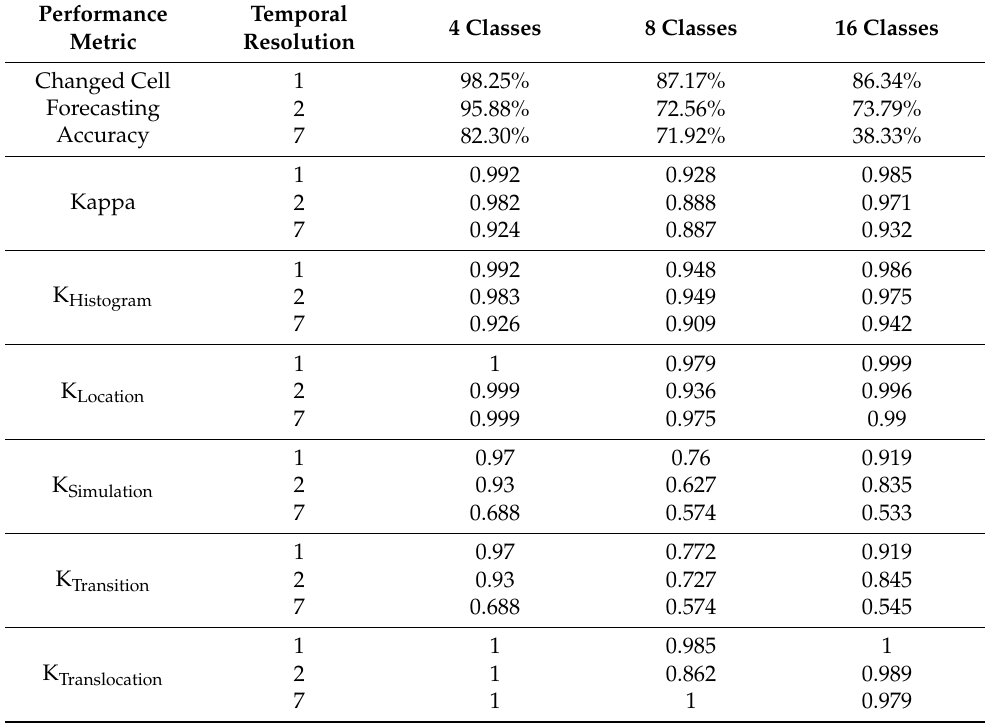
Table 10. Performance metrics obtained using Subset C of the hypothetical dataset (including timesteps 30 to 45), featuring 15-year LC datasets with 4, 8, and 16 classes.